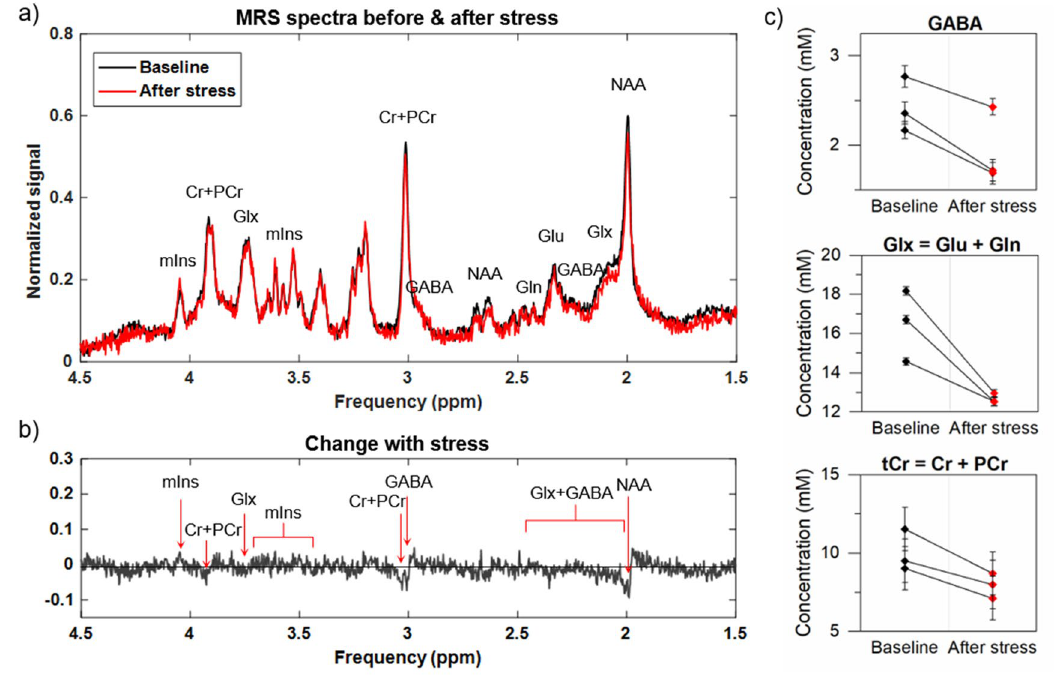
Figure 7. ( a ) Typical MRS spectra measured in a representative rat hippocampus before stress (black line) and after (red line). The lowering of the major peaks of N -acetyl aspartate (NAA) and total creatine (creatine + phosphocreatine, tCr = Cr + PCr), as well as of the signal within the 2–2.5 ppm range, where the Glx complex (glutamate + glutamine, Glx = Glu + Gln) and γ-aminobutyric acid (GABA) contribute to the spectrum are visible. The increase of myo-inositol (mIns) is also noticeable. ( b ) The residuals after subtracting the baseline from post-stress spectra. ( c ) The absolute concentrations of GABA, Glx and tCr were significantly lowered after stress, as revealed by t-test for paired samples (p = 0.03; 0.042; and 0.034, respectively). The error bars denote the fitting errors computed as SD of the model from the original data.